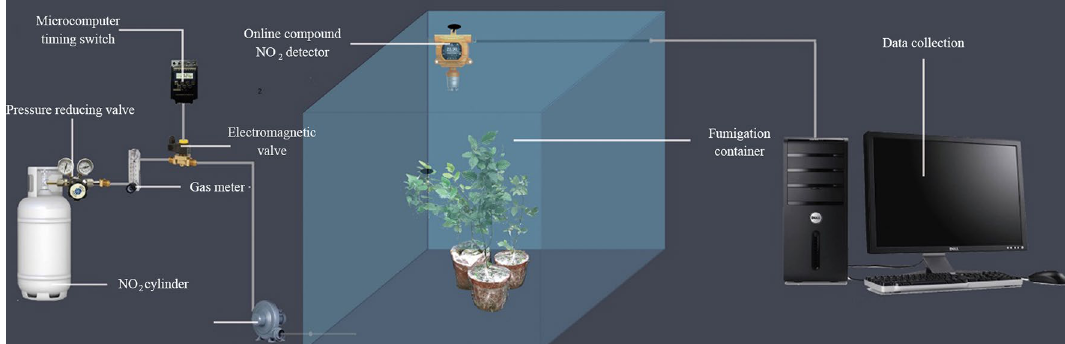
Figure 7. The fumigation test device for timing regulation and recording of the NO 2 concentration (drawn with Adobe Photoshop CC2019; https:// downl oad. zol. com. cn/ tuigu ang/ detail/ 46/ 456409. shtml? qw